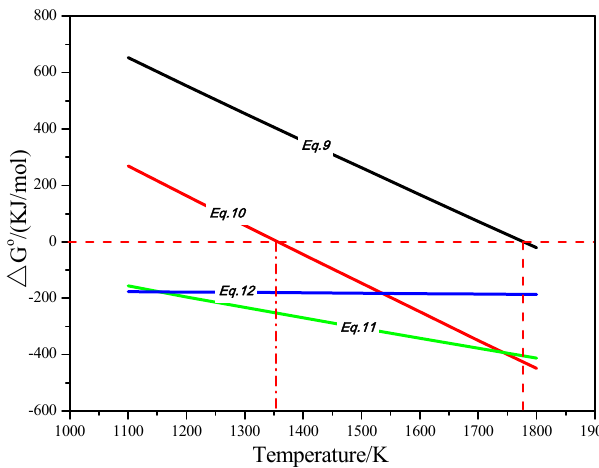
Figure 5. Correlation of standard free energy with temperature for Equations (9)–(12).